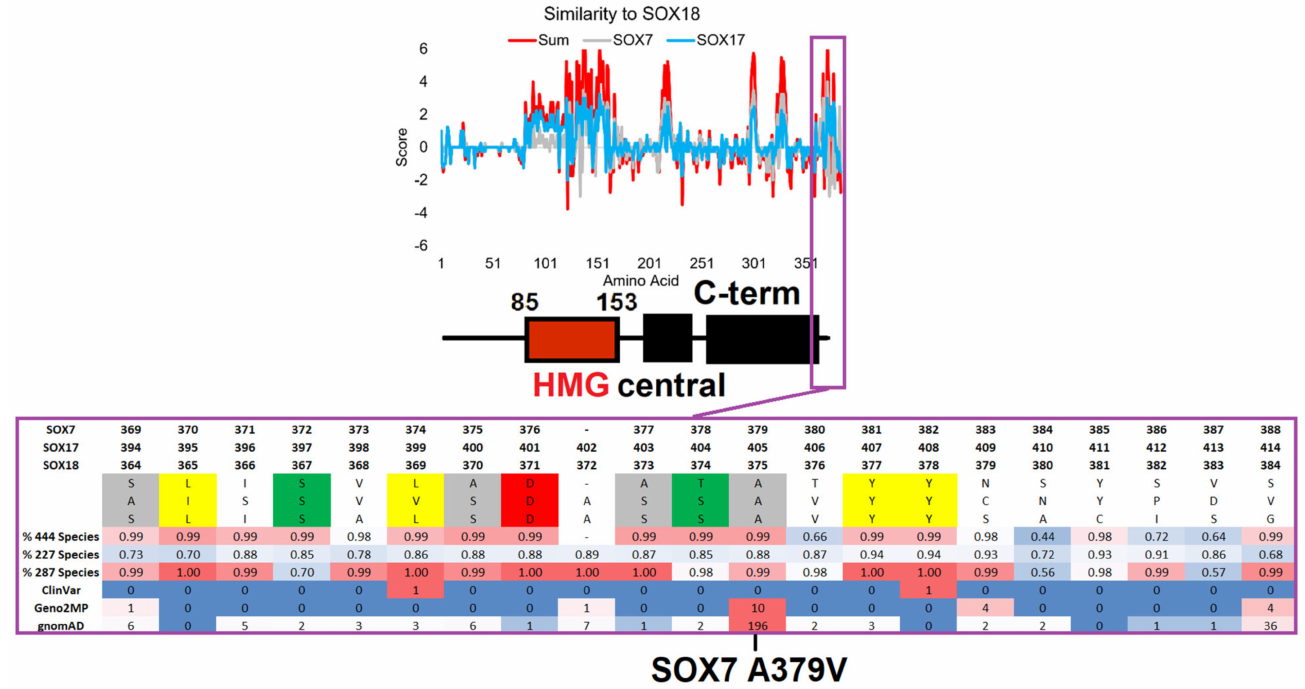
Figure 6. Conservation of the SOX-F proteins highlighting the far C-terminal region. The top panel shows a comparative analysis of SOX18 relative to the SOX7 (gray) and SOX17 (cyan) conservation scores for each amino acid of SOX18, with the SOX18 domain annotation from Figure 1 shown below. When the amino acids are the same between SOX18 and the others, they have positive values; when they are different, the values are negative. The red line is the additive value of the SOX7 and SOX17 comparisons. In the bottom panel, the magenta call out shows the conservation of amino acids within the far C-terminal region of SOX-F members. The amino acid numbers of each protein are provided on top of the sequences. This is followed by the human amino acids, where those highlighted are conserved in each sequence (gray—flexible; yellow—hydrophobic; green—S or T; red—polar acidic). Then, the percentage of conservation for the amino acid sequence alignments is shown, with a value of 1 indicating 100% conservation. At the bottom is the number of variants seen in each genomics database. The conservation and variants are shown on a heatmap, with red representing the highest values and blue representing the